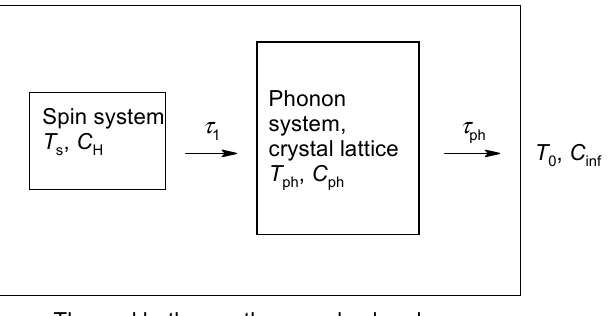
Figure 2. Energy flow from the spin system through the phonon system to the thermal bath.